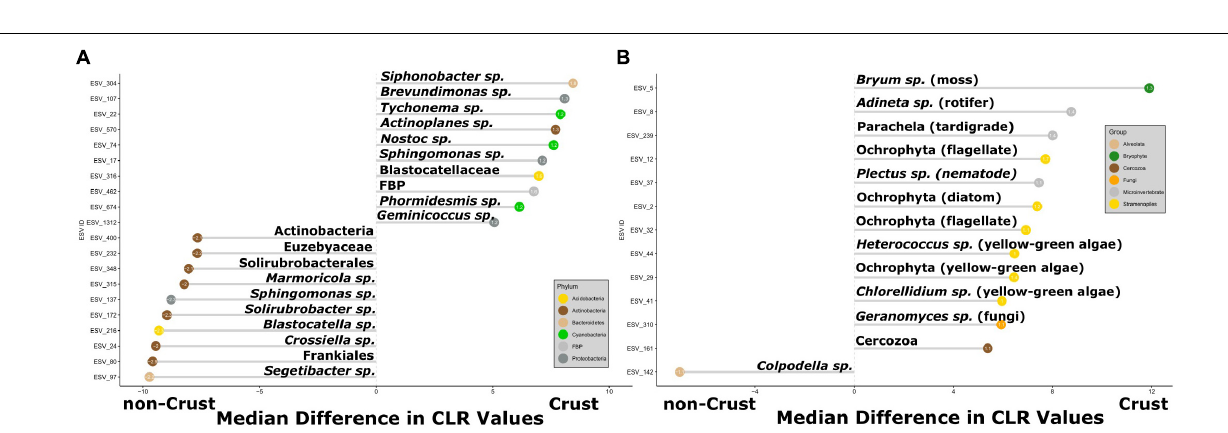
FIGURE 4 | Organisms with the greatest differential relative abundances between samples from crust communities and those from non-crust communities (A) 16S, and (B) 18S. The x -axis displays the difference in median center-log ratio (CLR) transformed abundances and only ESVs with effect sizes > 1 or < –1 and p -values < 0.05 are displayed. The value inside the dot is the effect size. The positive values indicate ESVs in crusts and negative values indicate ESVs in non-crusts. Each ESV is labeled with the lowest taxonomic assignment from the SILVA 132 or NCBI GenBank databases. The colored dots refer to bacterial phyla or higher-level taxonomic grouping for Eukaryotes.